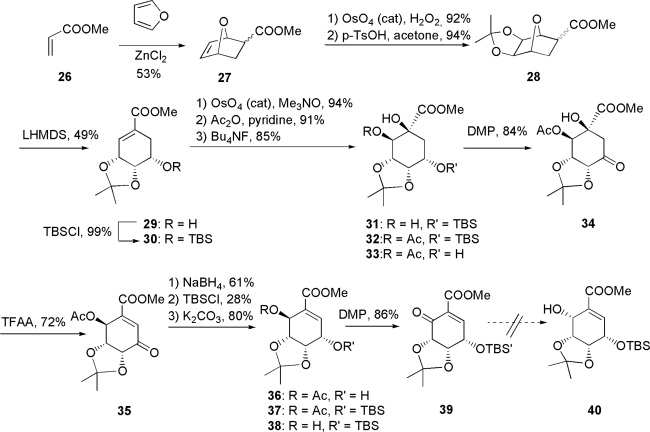
Usami’s approach.